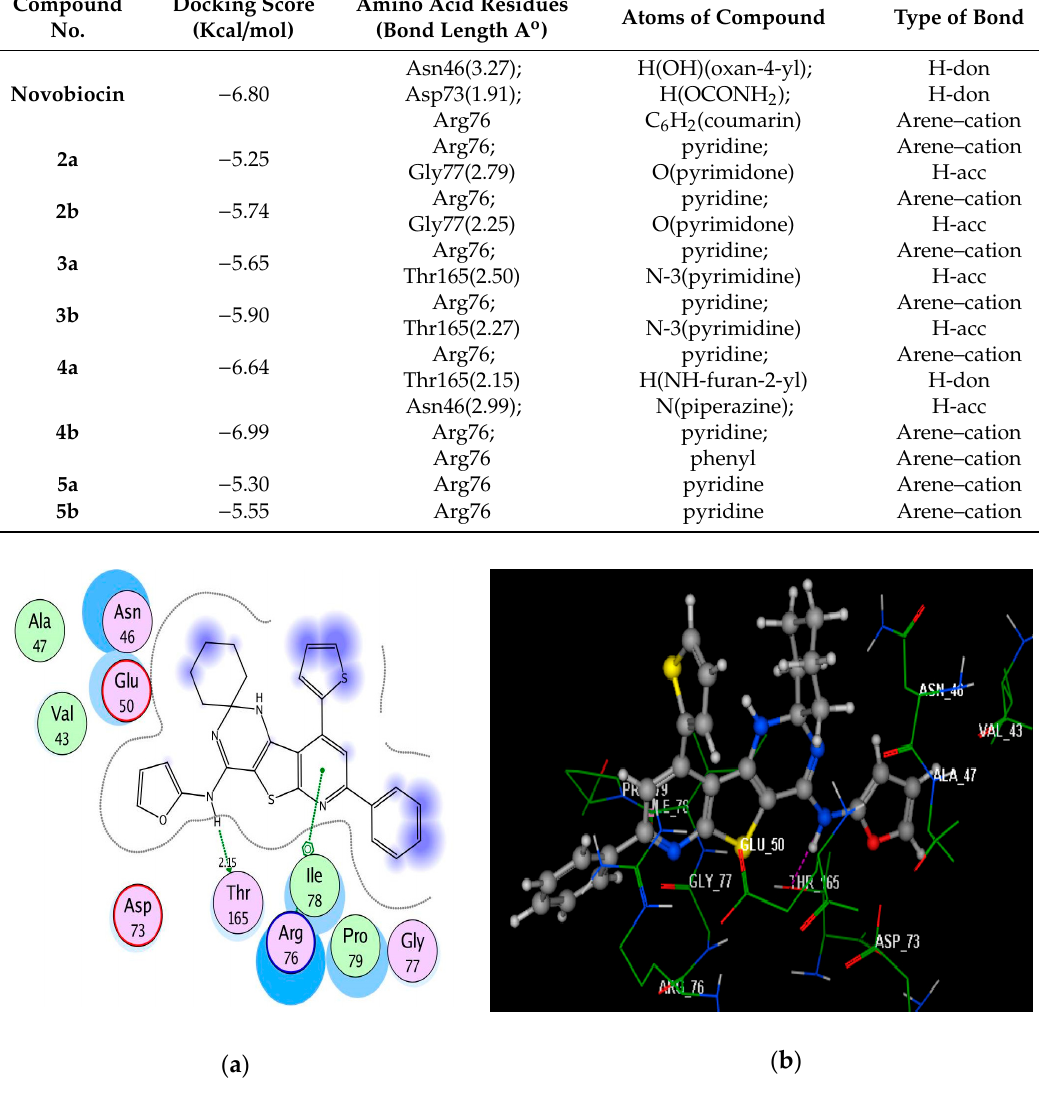
Table 3. Docking results of compounds 2a , b ; 3a , b ; 4a , b ; and 5a , b with E. coli DNA gyrase B kinase using MOE software version 2008.10.